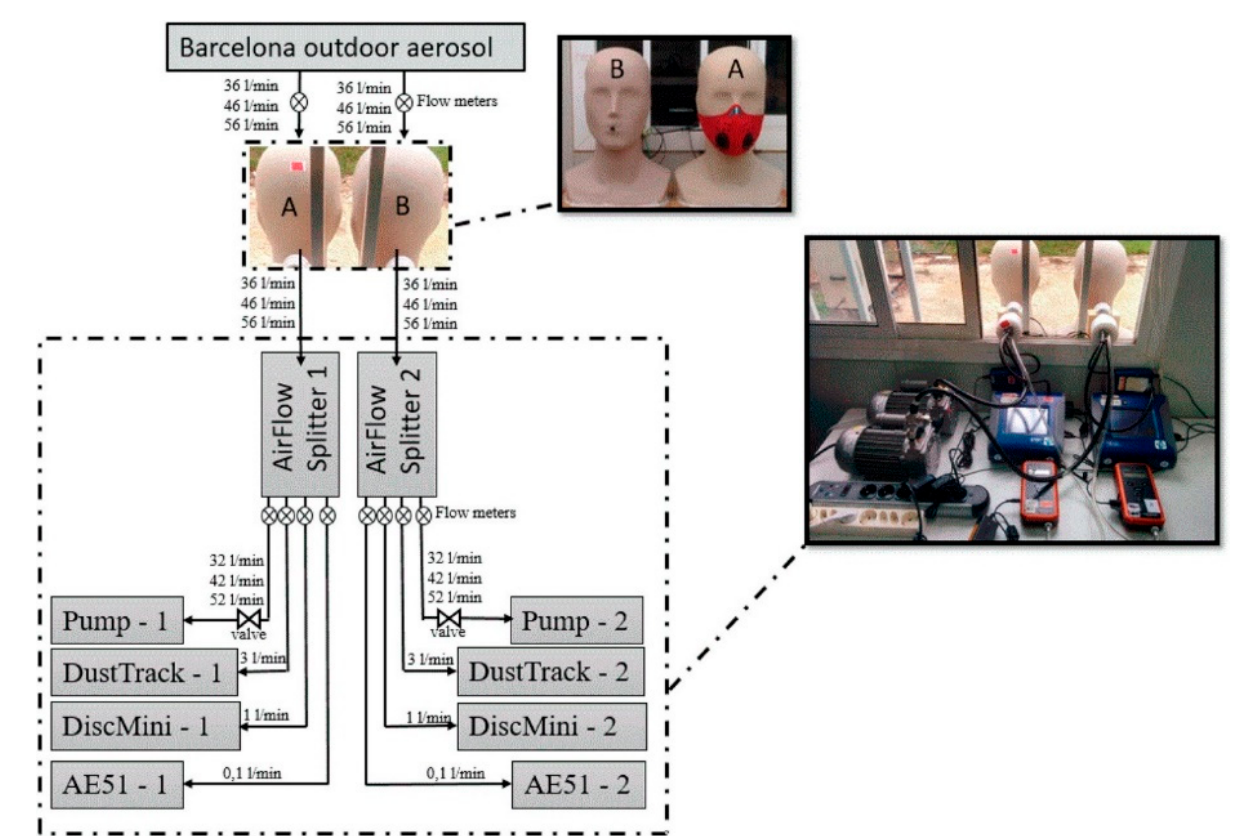
Figure 13. Set ‐ up illustrations for measuring performance [59]. Figure 13. Set-up illustrations for measuring performance